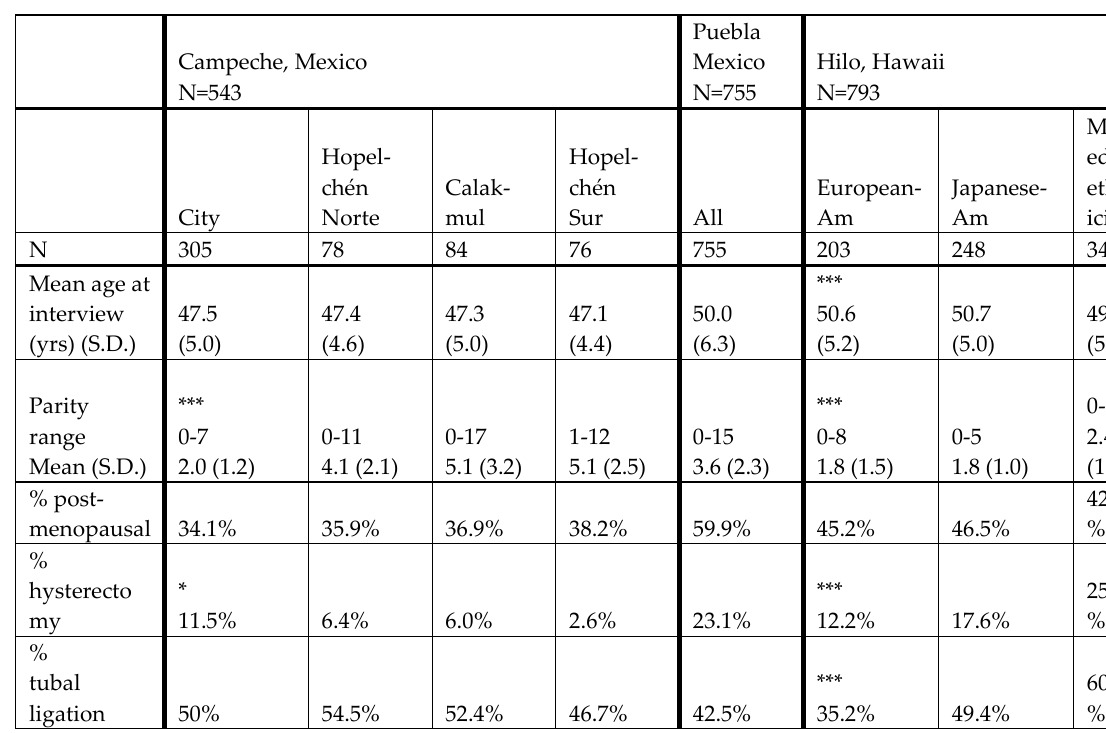
Table 1: Sample characteristics. Comparisons across four subgroups within Campeche, and three subgroups within